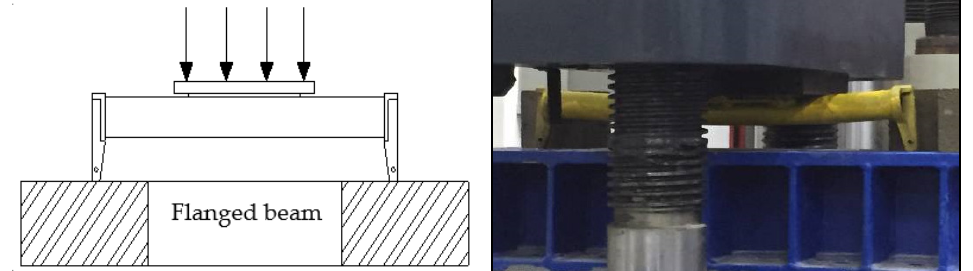
Figure 8. Experimental device for measuring the bending capacity of a horizontal bar.